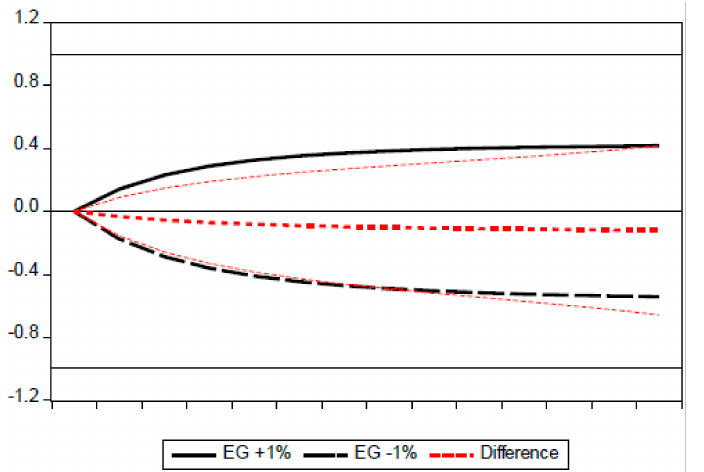
Figure 1. Dynamic multiple adjustments of carbon emission to a unitary change of economic growth in